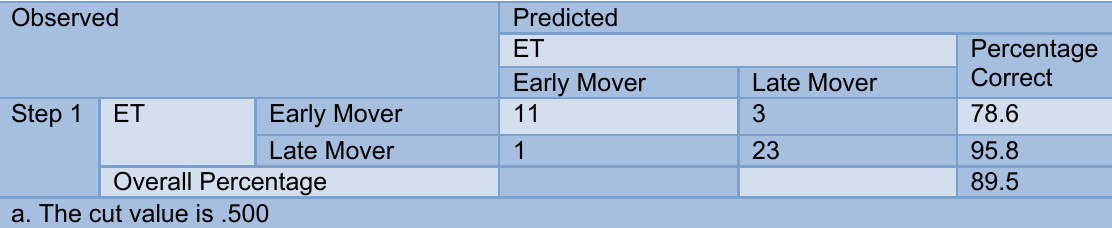
Table 9: Classification table with predictor variables for ET Decision a